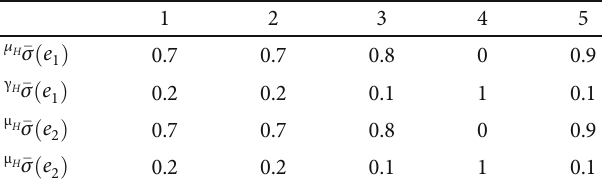
Table 13: Upper approximation of H .